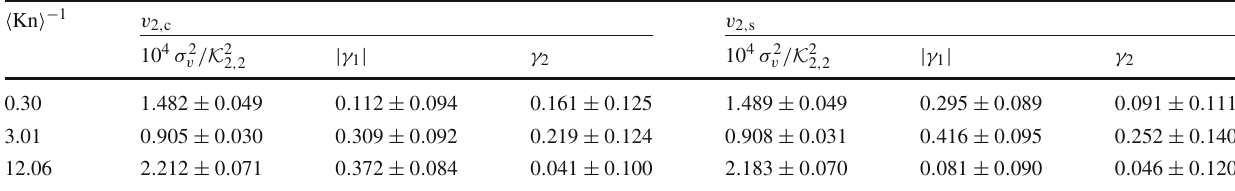
Table 9 Moments of the conditional probability distributions p v | ε (v 2 , c / s | ε 2 , c / s ) of the final-state flow harmonics computed for 10 4 events at b = 0 fm. The variance σ 2 v is divided by the square K 2